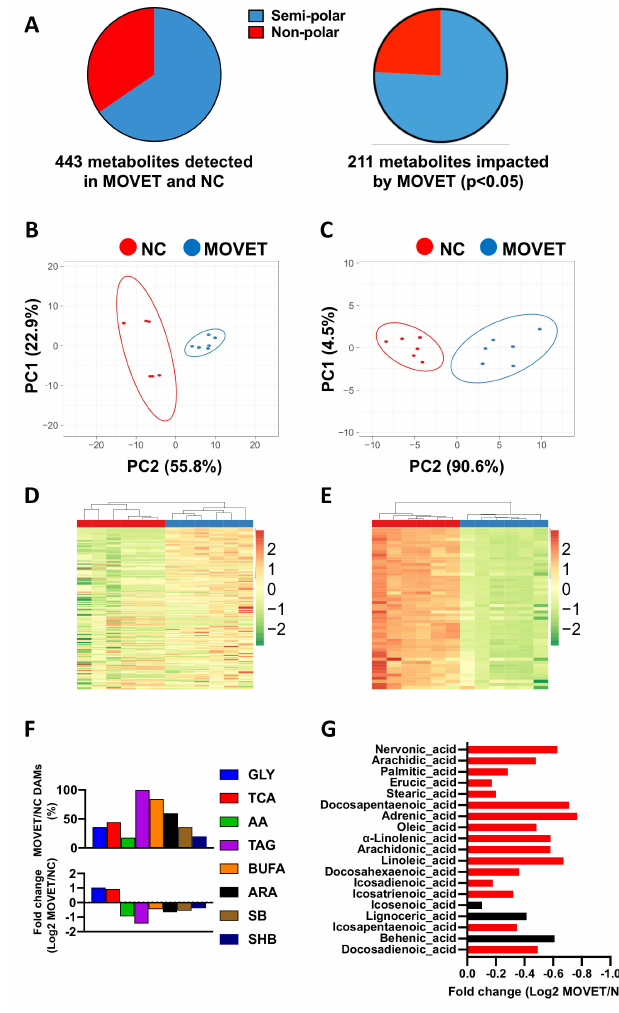
Figure 1. Metabolite profile changes in the liver of F3 generation animals derived from early embryos exposed to the combination of multiple ovulations, vitrification and embryo transfer (MOVET) and naturally conceived (NC) were compared. ( A ) Categorical distribution of the 443 metabolites detected by the untargeted analysis and the 211 differentially accumulated metabolites (DAMs) in VT rabbits. ( B ) Principal components analysis (PCA) of the untargeted semi-polar DAMs. ( C ) PCA of the